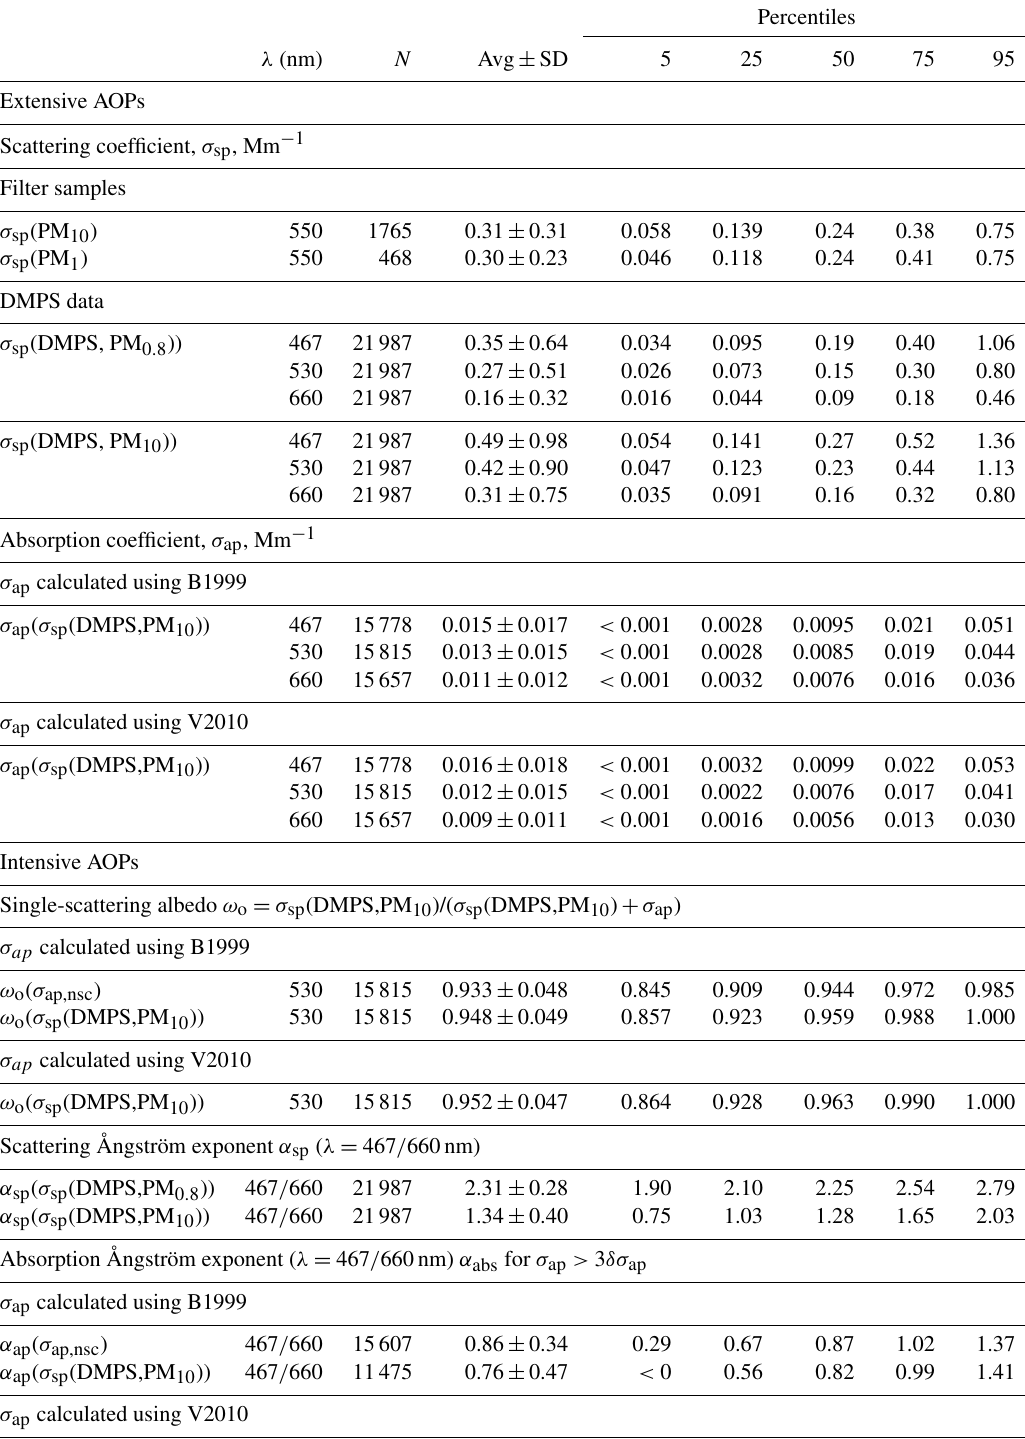
Table 5. Descriptive statistics of aerosol optical properties at Dome C in 2008–2013. The statistics were calculated from the 24h running averages. λ : wavelength; N : number of data points used for the statistics, for filter sample number of filters. Avg ± SD: average ± standard deviation. See details and explanations of other symbols in the